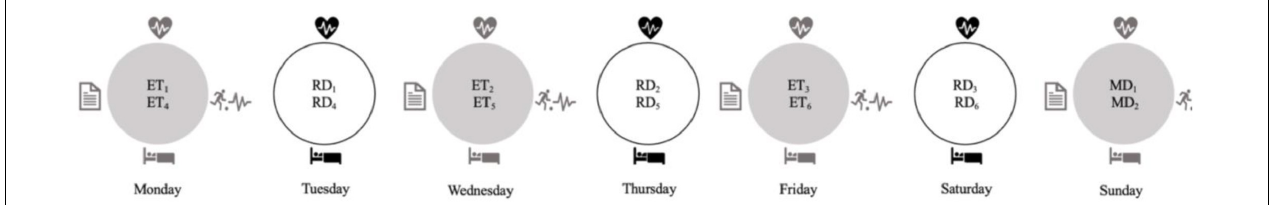
FIGURE 1 | Schematic showing the study design. Heart rate, session-rating of perceived exertion and perceived ratings of wellbeing included evening-time training sessions (ET) and match-days (MD). During night-sleep of the 14 days, including rest-days (RD), sleep and nocturnal heart rate variability indices were assessed using heart rate monitors and accelerometers,